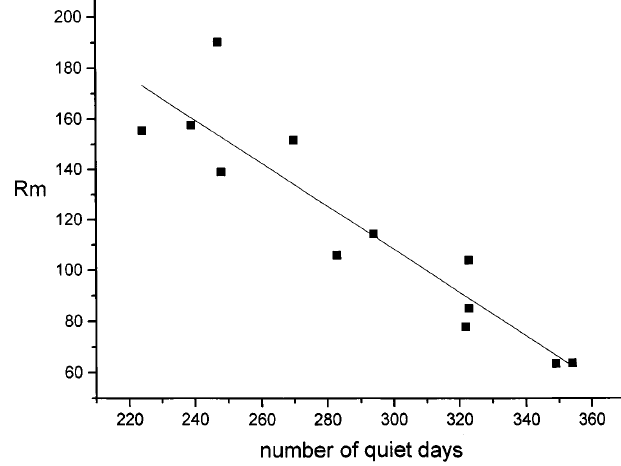
Fig. 1. Linear regression between the annual number of quiet days ( aa < 20 c ) of the year after the minimum of the cycle in progress and the maximum sunspot number of the next cycle Rm : Rm = ) (0.85 (cid:139) 0.1) aa + (364.44 (cid:139) 34.3), with r = 0.92. Cycles 11 to 22 are used